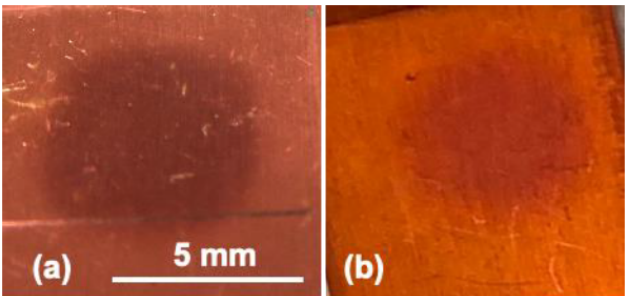
Figure 2. Photographs of the surface of samples irradiated with 5 keV-Ar + ions to fluences of 1 × 10 15 cm − 2 ( a ) and 1 × 10 14 cm − 2 ( b ). The photographs were taken after removing the samples from the vacuum chamber.